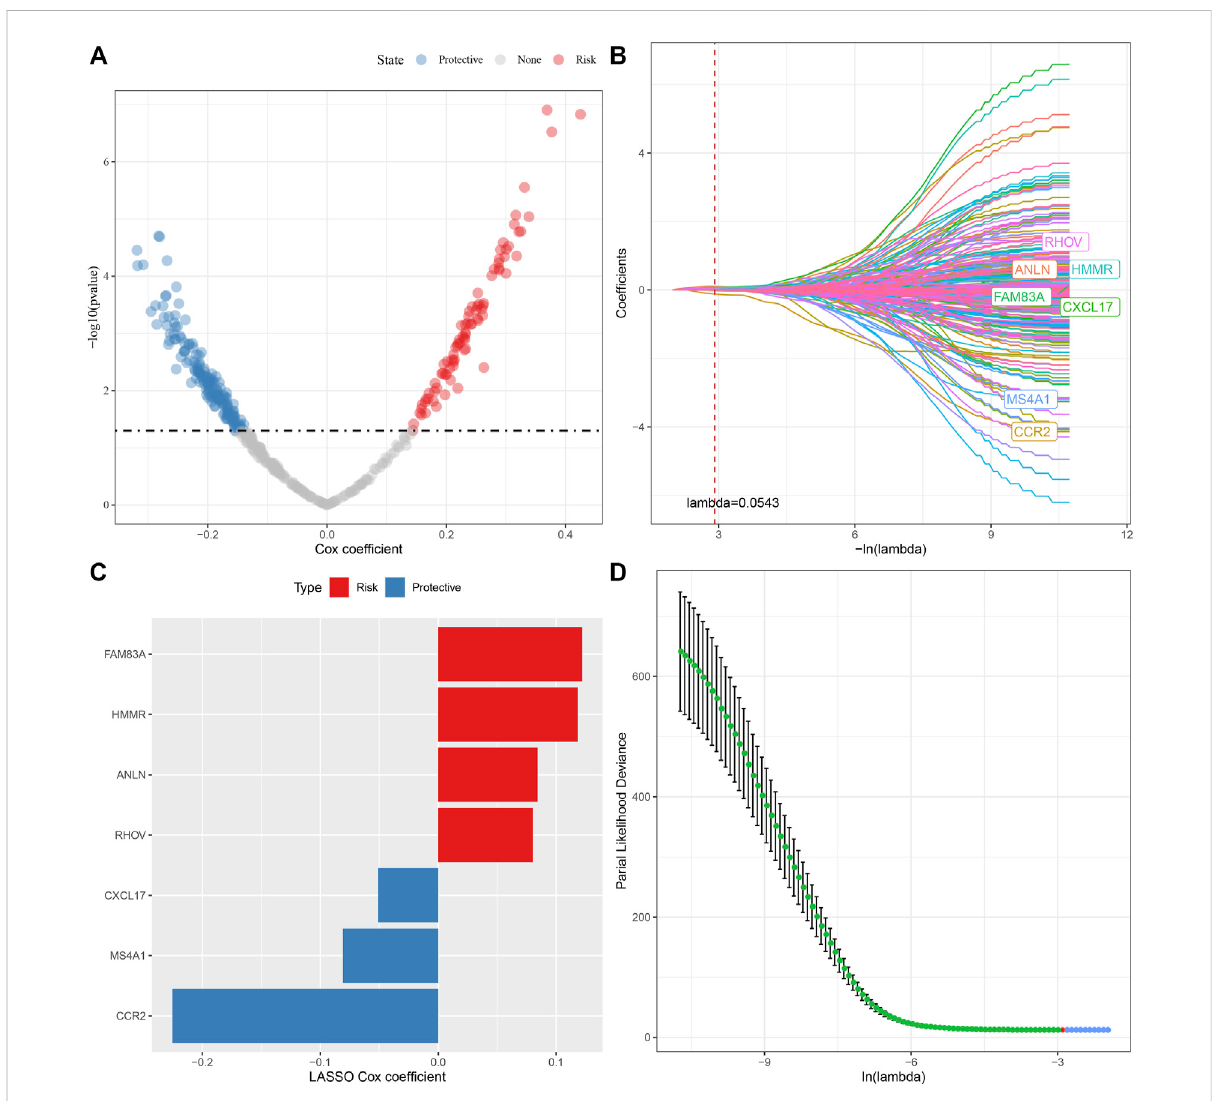
enrichment analysis of differentially downregulated genes among C1 vs. C2, C1 vs. C3, and C2 vs. C3 subtypes, the results showed that there were fewer differential pathways among C1 vs. C2 subtypes, while there were more differential pathways among C1 vs. C3 and C2 v sC3 subtypes, especially among C2 vs. C3 subtypes, and the down-regulated genes among these subtypes were substantially enriched in some immune and in fl ammatory-related differential pathways (Figure